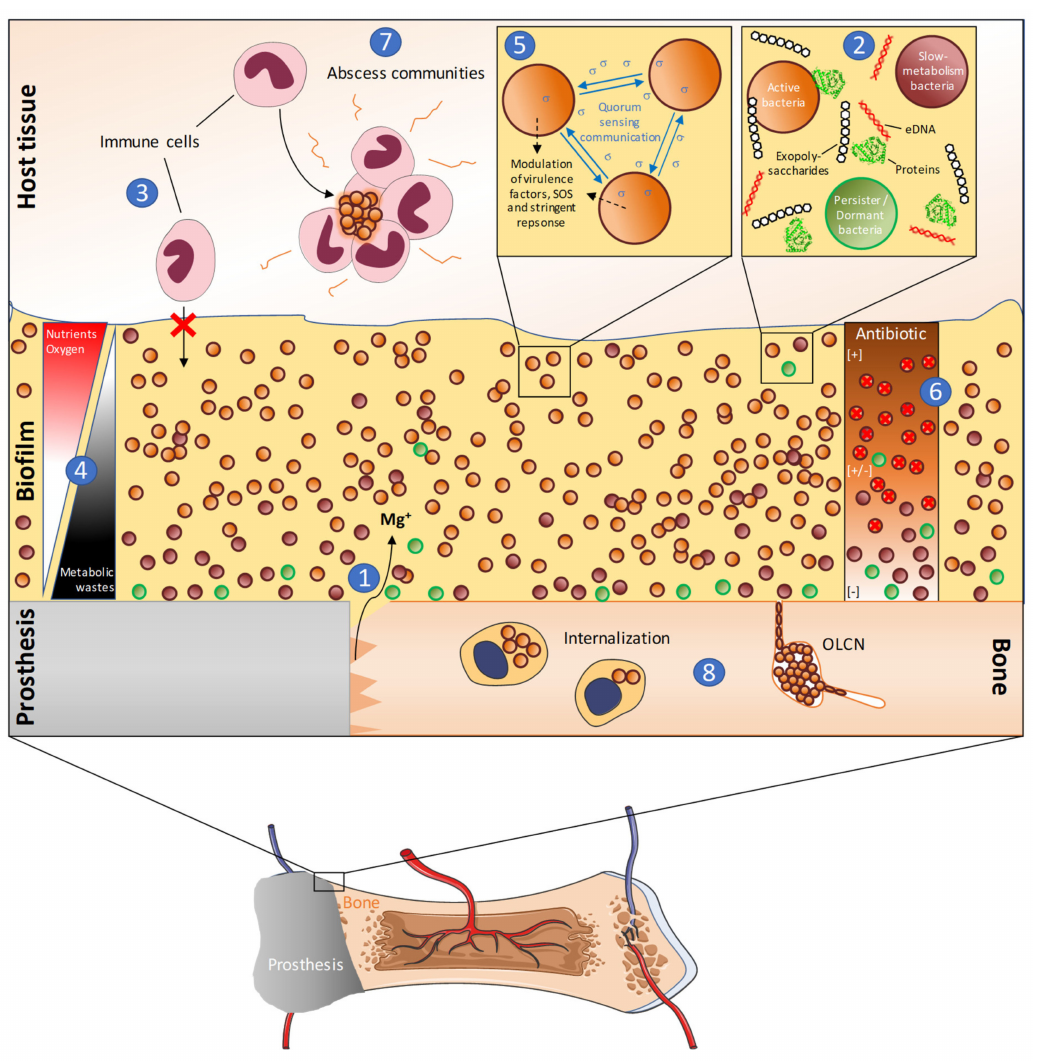
Figure 2. Representation of Periprosthetic Joint Infection involving S. aureus biofilm and